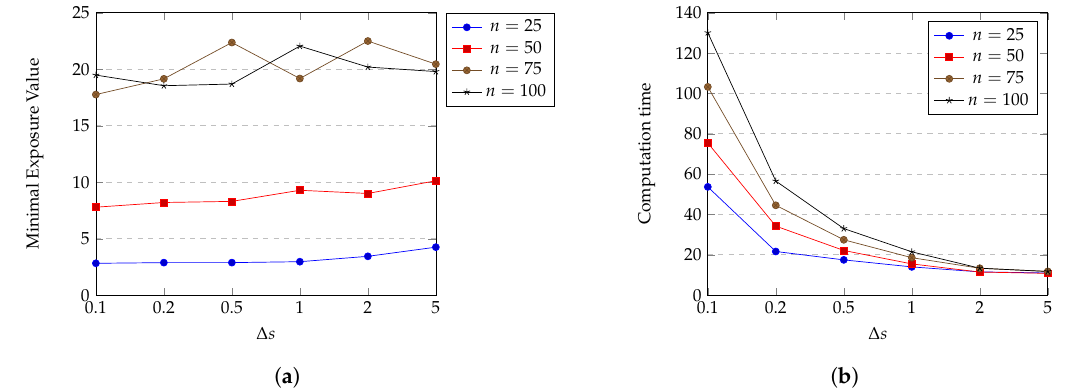
Figure 9. Effect of ∆ s on ( a ) minimal exposure value; ( b ) computation